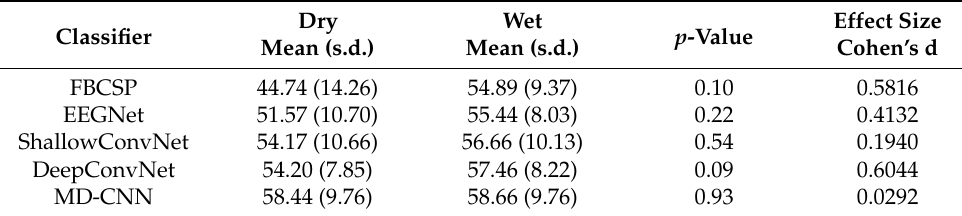
Figure 5. Classification accuracy of the FBCSP, EEGNet, ShallowConvNet, DeepConvNet, and MD-CNN models. The horizontal dotted line indicates the chance level. Table 2. Comparison of classification accuracy between dry and wet electrode BCI systems.